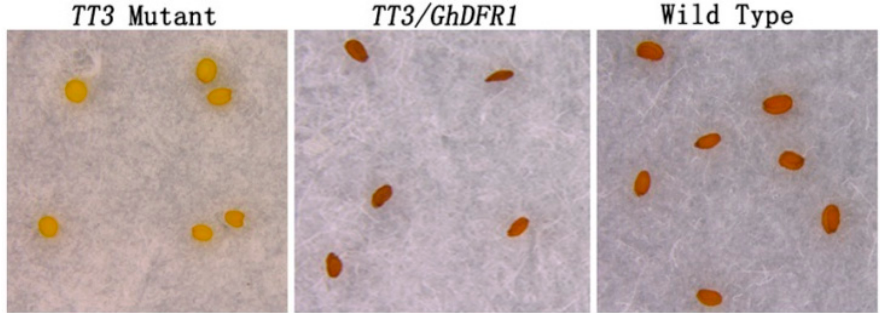
Figure 7. Ectopic expression of GhDFR1 in an Arabidopsis thaliana TT3 mutant. Seed coloration of TT3 mutant, ectopically expression GhDFR1 , and Columbia wild-type plants.